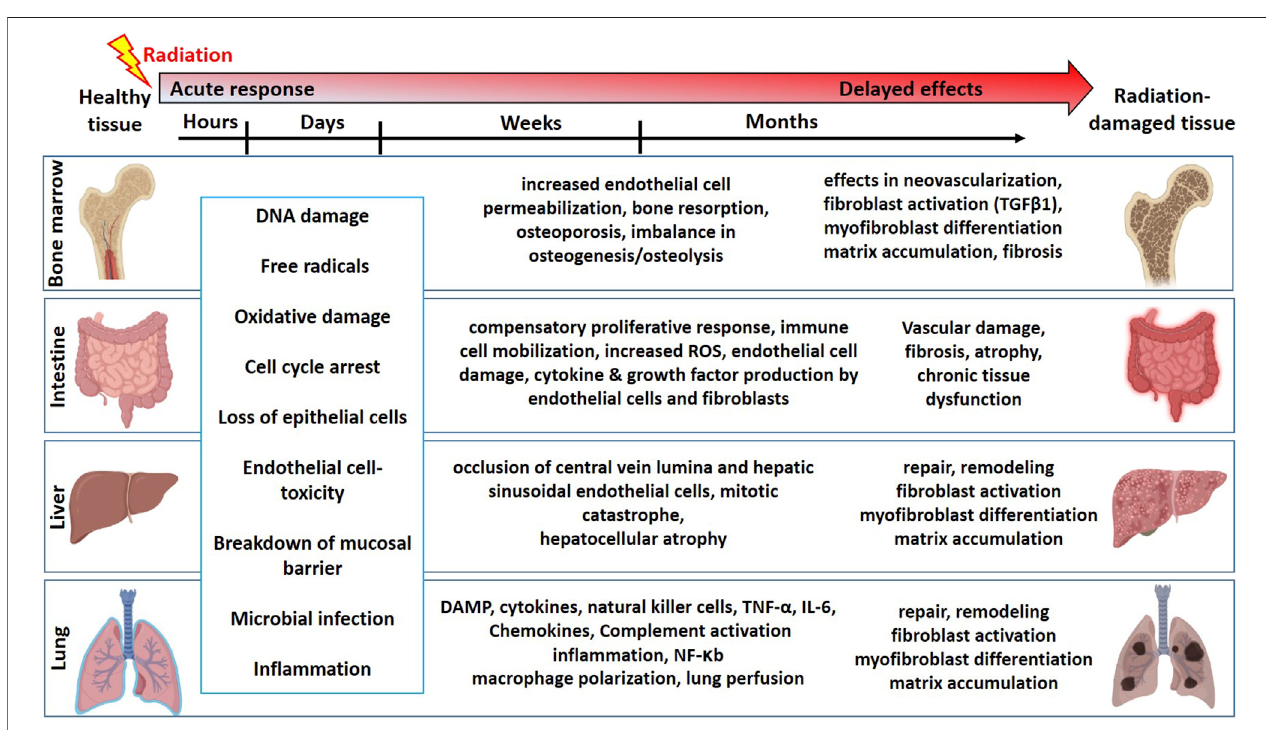
FIGURE 1 | The timeline and pathophysiologic changes in the bone marrow, intestine, liver, and lung for the development of normal tissue toxicity after high dose radiation exposure (Graphics adapted from BioRender.com).